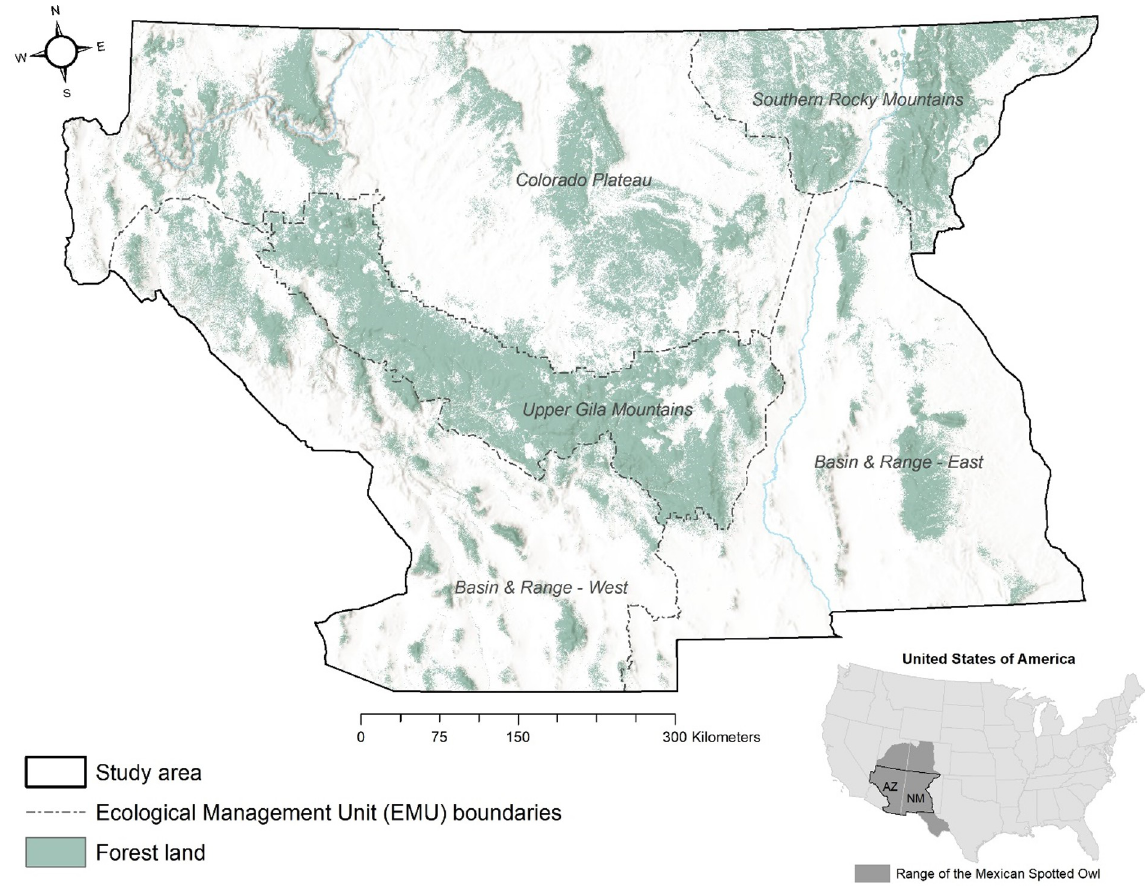
Fig 1. Study area map. Map shows the study area in Arizona and New Mexico, displaying boundaries of Ecological Management Units defined in USFWS (2012) and the extent of forested lands (National Land Cover Database). Inset shows the location of the study area relative to the range of the Mexican spotted owl within the